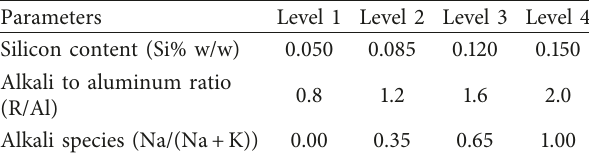
Table 2: Parameters and their variation